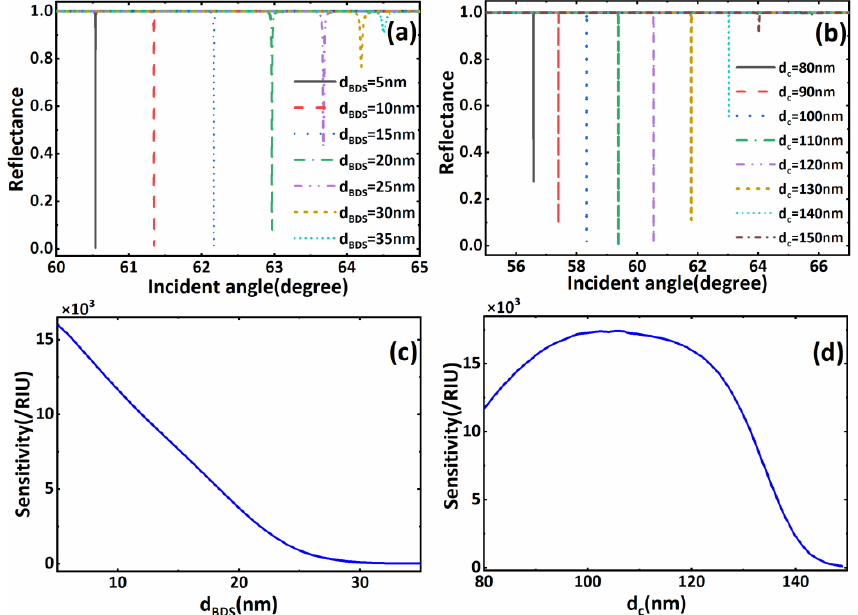
Figure 5. ( a ) The reflection spectrum versus incident angle with different d BDS ; ( b ) The reflection spectrum versus incident angle with different d c ; ( c ) The sensitivity curve with d BDS at d c = 120 nm; ( d ) The sensitivity curve with d c at d BDS = 5 nm. The other parameters have the same values as those in Figure 2.